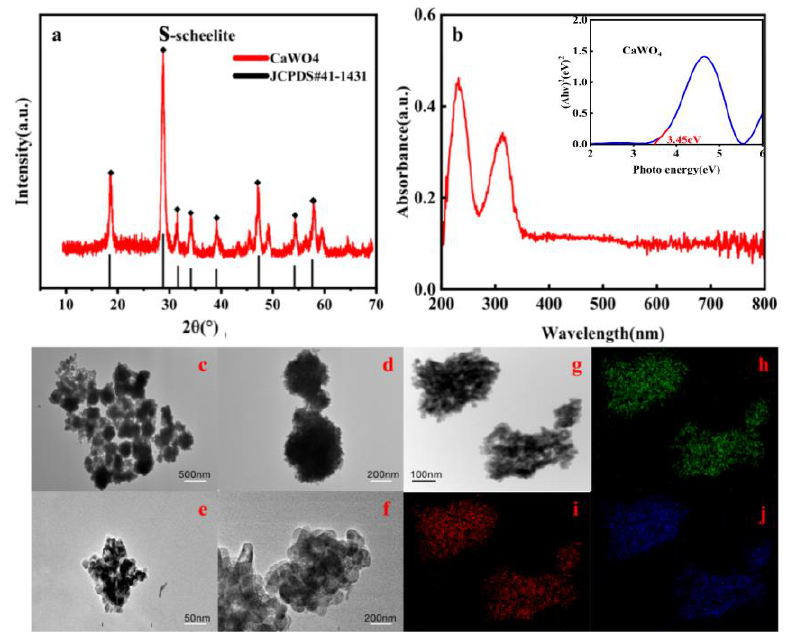
Figure 1. ( a ) XRD patterns of CaWO 4 ; ( b ) UV – Vis DRS spectra of CaWO 4 ; ( c – g ) TEM images of CaWO 4 ; ( h – j ) Element mapping images of Ca, W, and